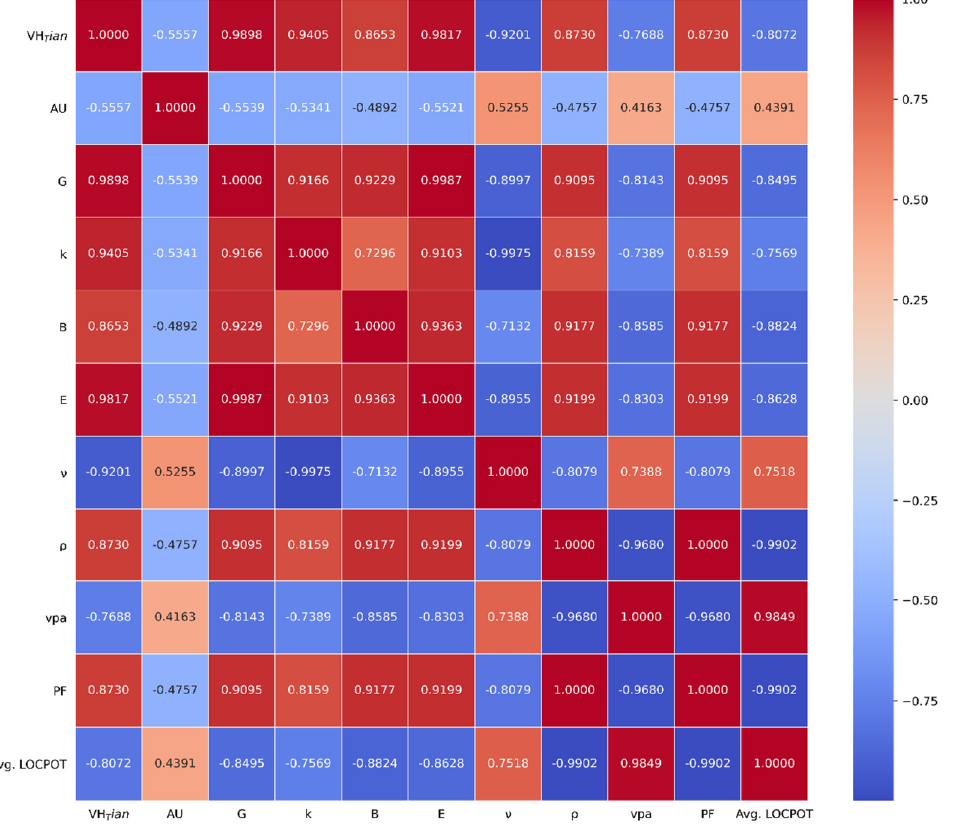
Figure 3. Pearson correlation matrix between Vickers’ hardness from Tian’s model ( VH Tian ), universal anisotropy (AU), shear modulus ( G ), Pugh’s ratio ( k ), bulk modulus ( B ), elastic modulus ( E ), Poisson’s ratio ( ν ), density ( ρ ), volume per atom (VPA), packing fraction (PF), and average local potential (Avg. LOCPOT).